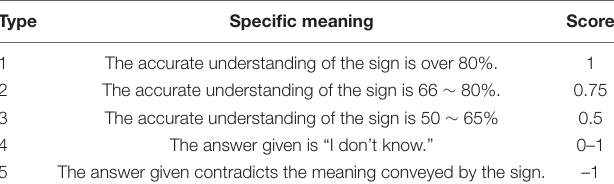
Table 1 . Cronbach’s alpha coefficient value of the scale was 0.96, indicating high reliability of the scale (Duarte and Rebelo,